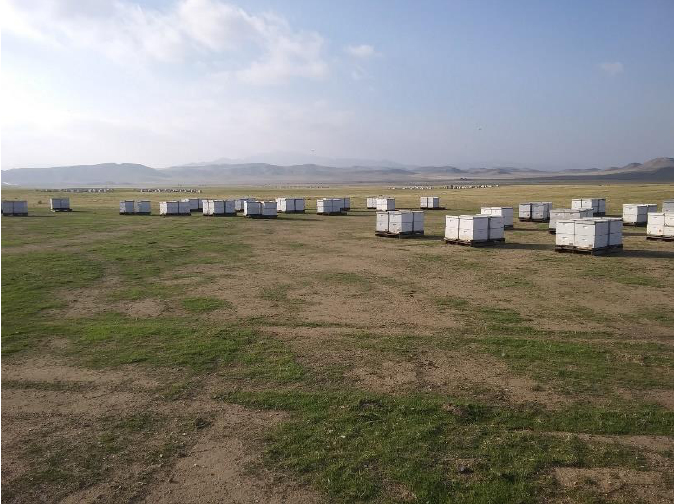
Figure 2. Experimental colonies used in the study in a holding yard, prior to almond pollination,